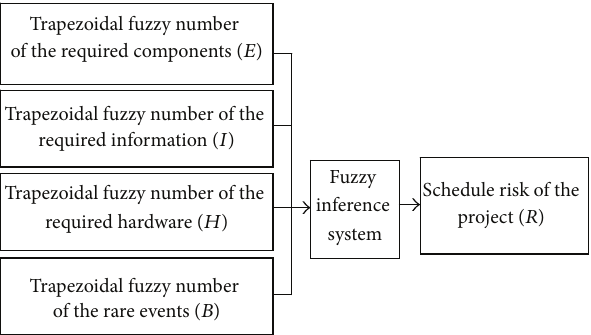
Figure 3: A framework for predicting the project’s scheduled risk (delay risk) based on Mamdani fuzzy